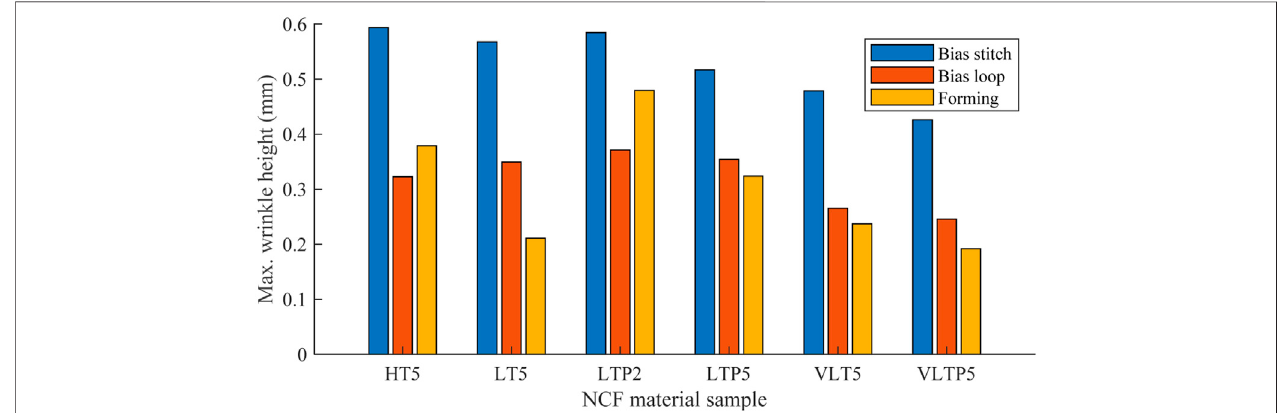
Frontiers in Materials |